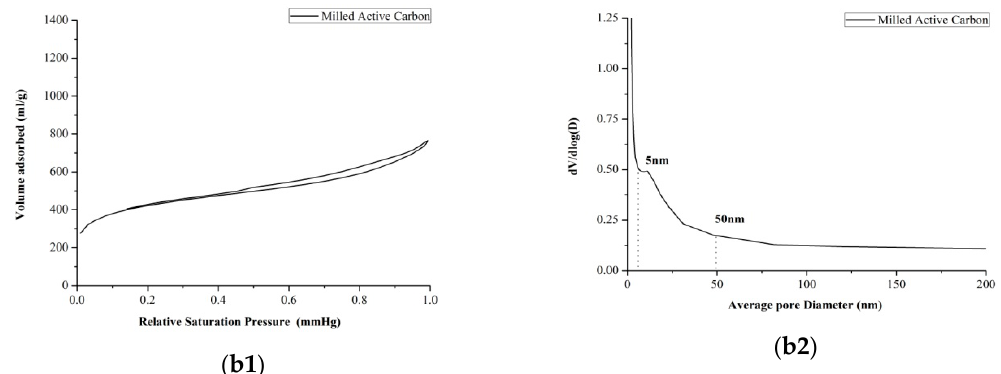
Figure 5. Isothermal adsorption curves of ( a1 ) Active carbon. ( b1 ) Milled active carbon (powder-to-ball weight ratio at 1:5, rotation rate at 200 rpm and milling 5 min) and pore size distribution curves of ( a2 ) Active carbon. ( b2 ) Milled active carbon (powder-to-ball weight ratio at 1:5, rotation rate at 200 rpm and milling 5 min)